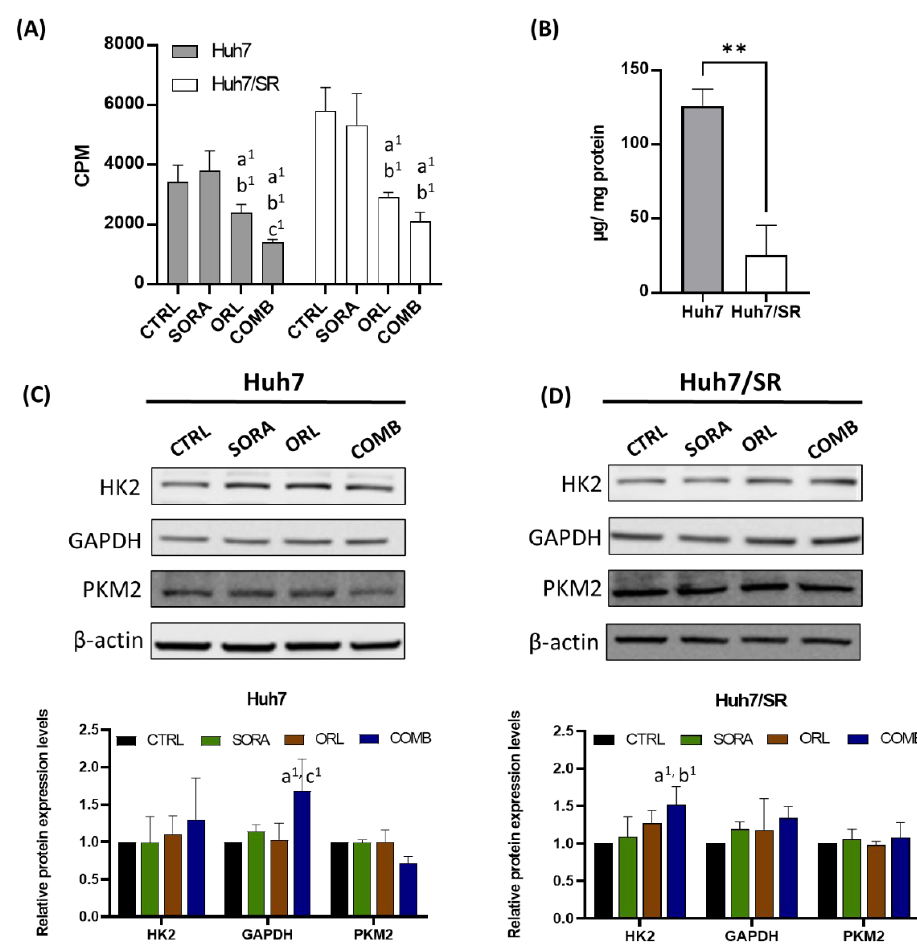
Figure 8. Combination treatment of sorafenib and orlistat diminished the elevated 18F-FDG uptakes detected in Huh7/SR cells and altered the expressions of glycolysis-related proteins. ( A ) Equal numbers of cells were cultured in the medium containing 18 F-FDG for an hour after receiving different treatments. Sorafenib treatment did not change the 18 F-FDG uptakes in both cell lines. However, the 18 F-FDG uptakes were suppressed by orlistat and combination treatment, and the reduction percentages were more prominent in Huh7/SR cells. ( B ) Huh7 cells had higher intracellular glycogen than Huh7/SR cells, indicating that excess glucose uptakes in Huh7/SR cells were utilized for energy production rather than storage. Changes in HK2, GAPDH, and PKM2 expressions caused by treatments in ( C ) Huh7 and ( D ) Huh7/SR cells were determined by Western blot. a, compared to Control; b, compared to Sorafenib; c, compared to Orlistat; 1 p < 0.05; ** p < 0.01 between two groups. An 18 F-FDG uptake assay showed that Huh7/SR cells took up more glucose than Huh7 cells. We then aimed to understand why Huh7/SR cells showed a higher uptake, and measured the intracellular glycogen level in both cell lines. Figure 8B shows that Huh7 cells had higher glycogen concentration than Huh7/SR cells, indicating that Huh7/SR cells might use more glucose for generating ATP and producing materials for fast cell